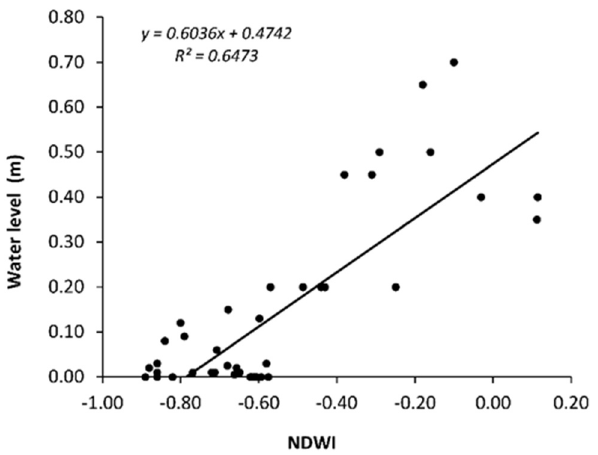
Figure 2. Mathematical adjustment between the 47 water level measurements taken in the rice fields during the winter flooding and the pixel values obtained with the NDWI index.